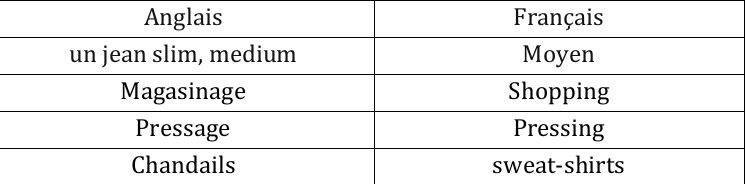
Tableu 3 Dans le monde de la mode